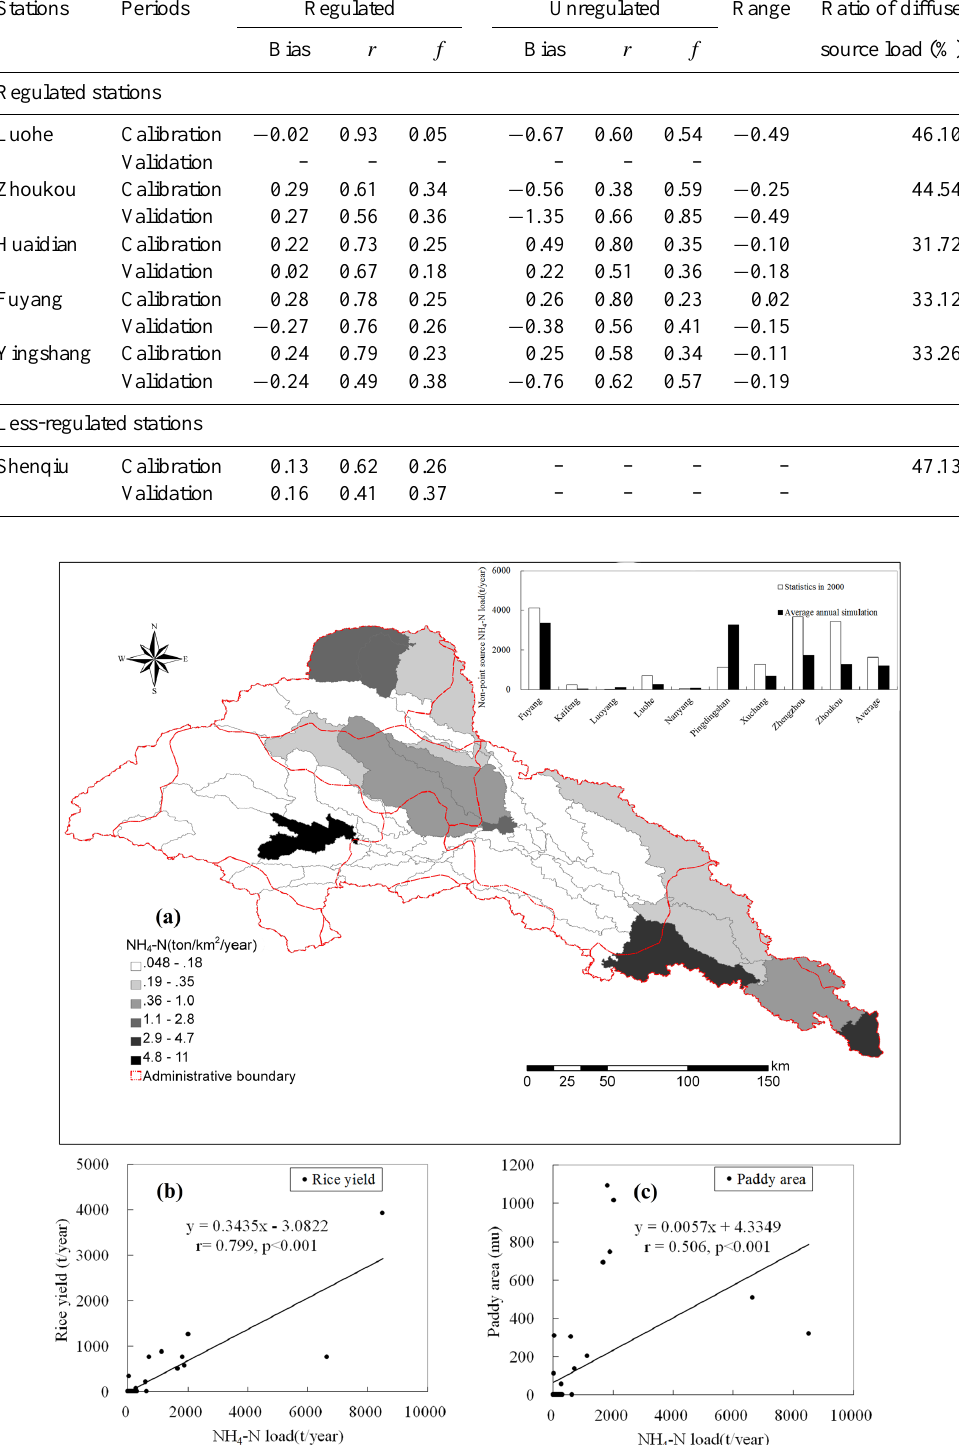
Figure 10. The spatial pattern of diffuse source NH 4 –N load (a) and its relationship with paddy area (b) and rice yield (c) at the sub-basin and regional scale in the Shaying River